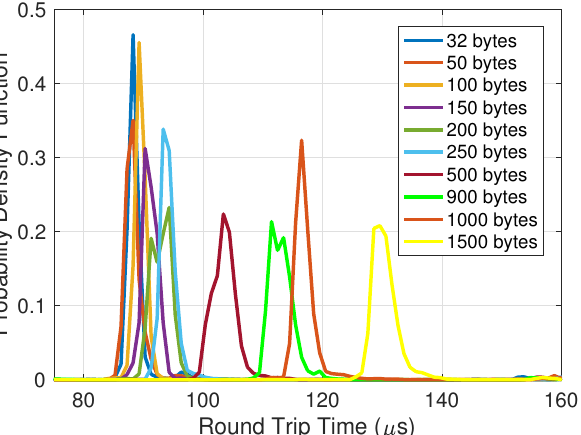
Figure 6. Distribution of latency on the Ethernet-based multi path fronthaul as a function of different packet